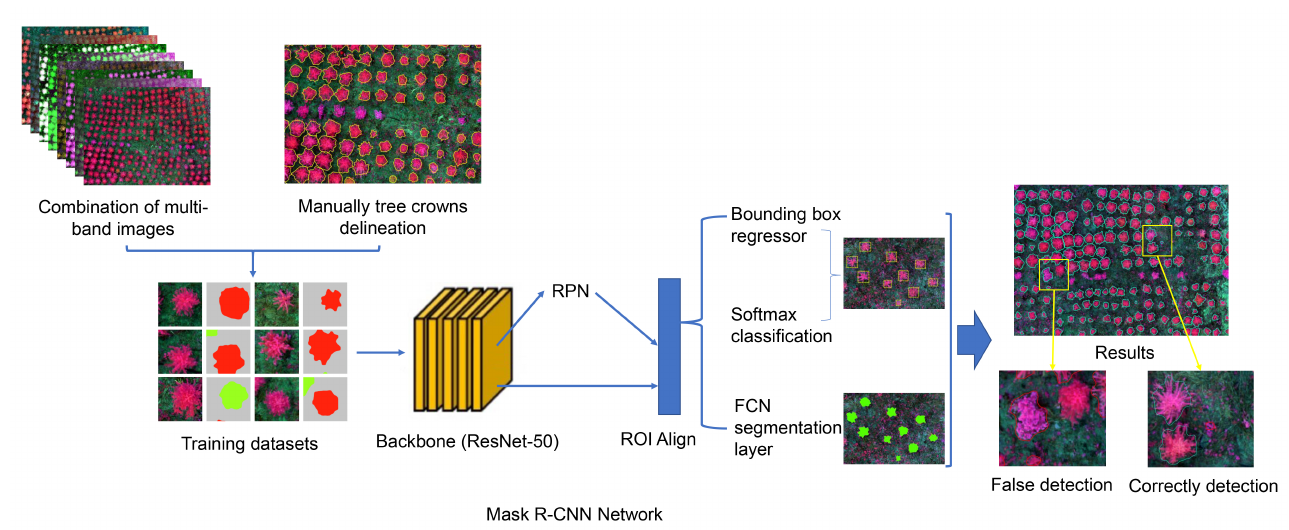
Figure 4. Overview of workflow for individual tree crown detection using Mask